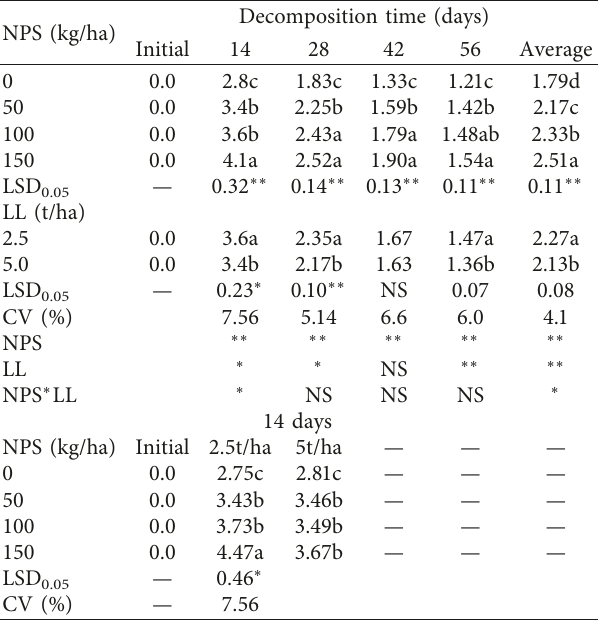
Table 2: Daily decay rate ( k ) (% day − 1 ) (dry weight bases) over 56 days of decomposition.